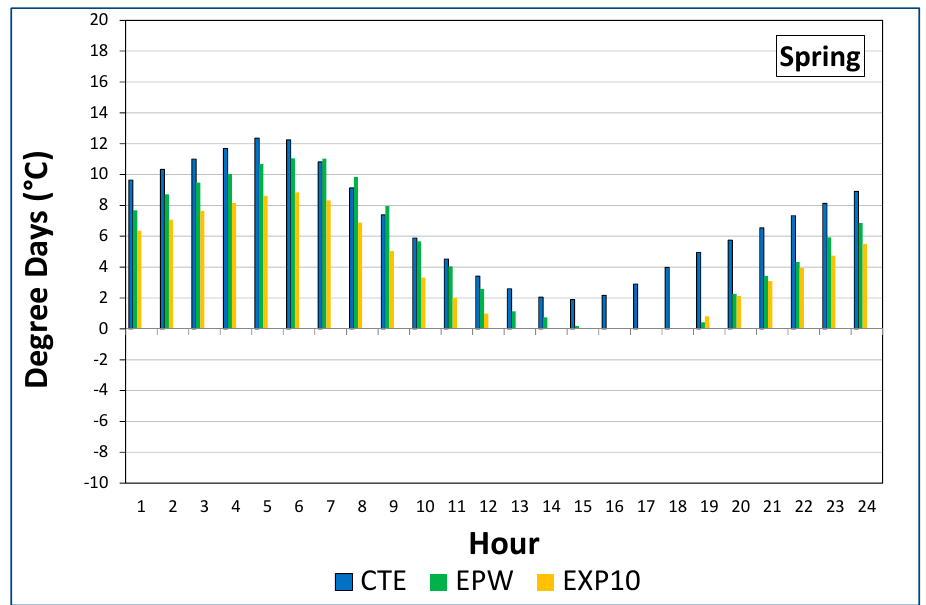
Figure 5. Average hourly degree-days of spring obtained for three climate databases of Madrid: CTE, EPW and Exp10.